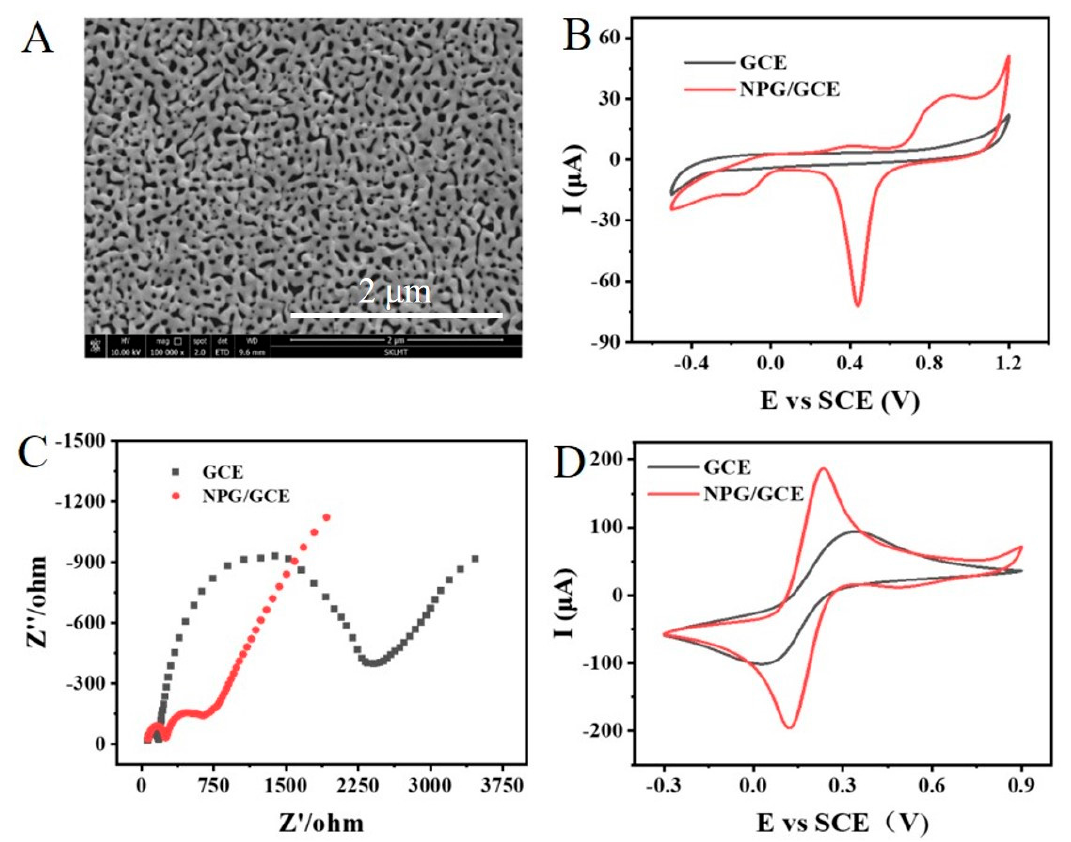
Figure 1. ( A ) The SEM image of NPG at a magnification of 100,000 ×. ( B ) The CV curves of bare GCE and NPG/GCE in PBS (50 mM, pH 7.0). ( C ) The EIS profiles of bare GCE and NPG/GCE in 5.0 mM K 3 Fe(CN) 6 solution (frequency range of 0.01 to 106 Hz). ( D ) The CV curves of bare GCE and NPG/GCE in 5.0 mM K 3 Fe(CN) 6 solution.